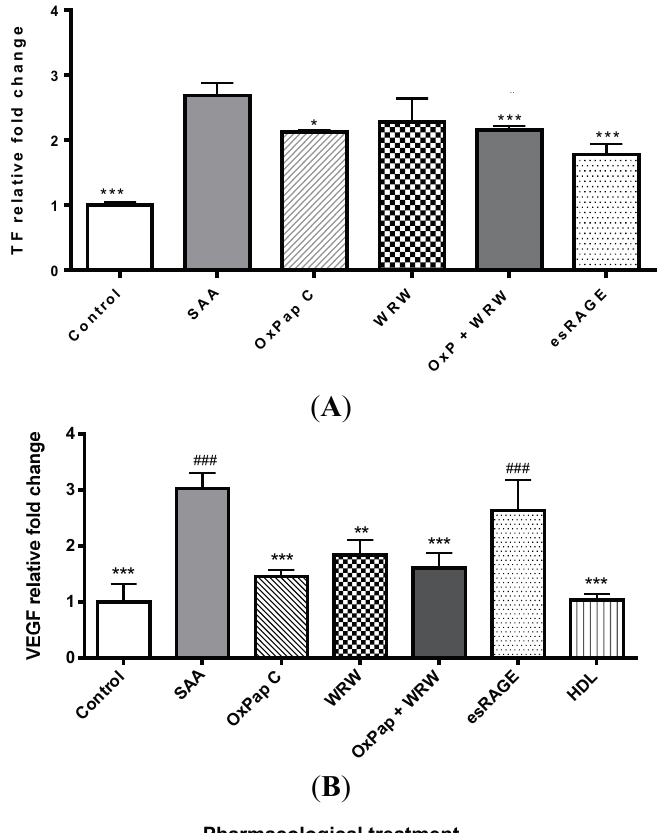
Figure 2. Suppression of SAA-induced TF and VEGF secretion by pharmacological agents and HDL. Cultured HCtAEC were treated with either vehicle (control) or pre-incubated with the indicated inhibitor (WRW4, 30 µg/mL; esRAGE, 15 µg/mL and OxPap C, 25 or 45 µg/mL) prior to the addition of SAA (10 μ g /mL). Cells were incubated for 4.5 h at 37 °C, harvested and the level of ( A ) TF and ( B ) VEGF protein assessed by ELISA. Data represents mean ± SD of n = 3 independent experiments, each performed in triplicate and expressed as fold-change relative to control. * p < 0.05, ** p < 0.01 and *** p < 0.001 different from SAA treated group without pharmacological inhibitors. ### p < 0.001 different from HDL pre-treatment